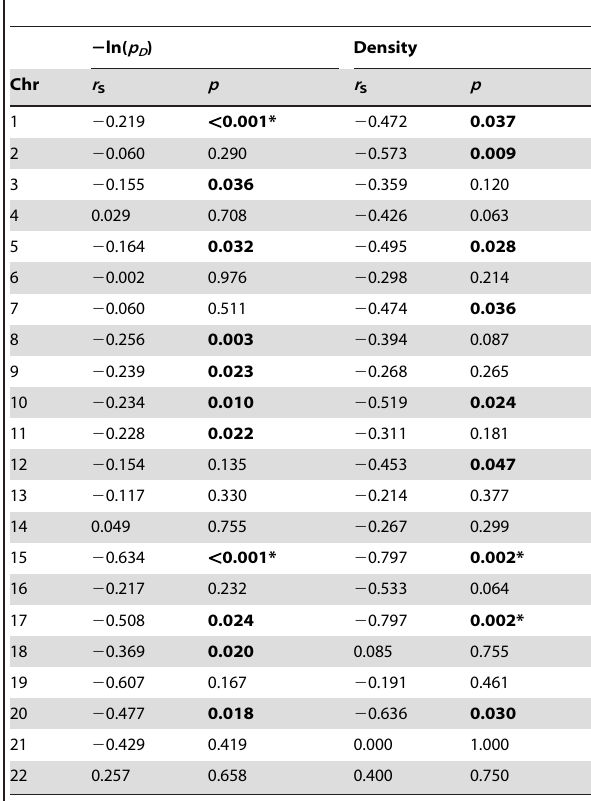
Table 4. Spearman rank correlations between 2 ln( p D ) and distance, and between patch density and